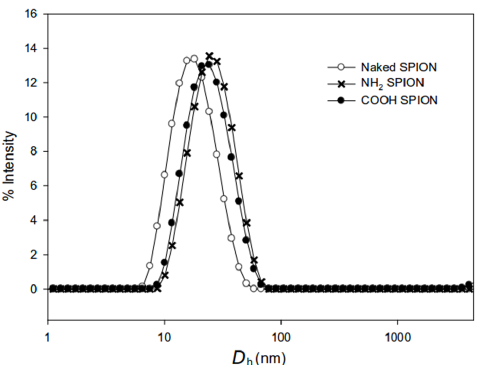
Fig 3. Particle size distributions of the a) bare, b) positively and c) negatively charged SPIONs. The charged SPIONs, due to their silica shell, were slightly larger than the bare